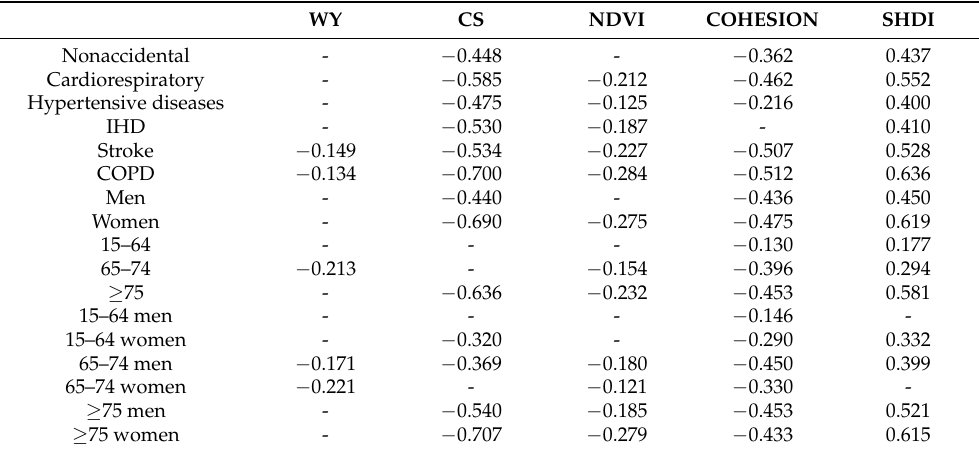
Table 2. The results of mediating effects of ESs on mortality risks through